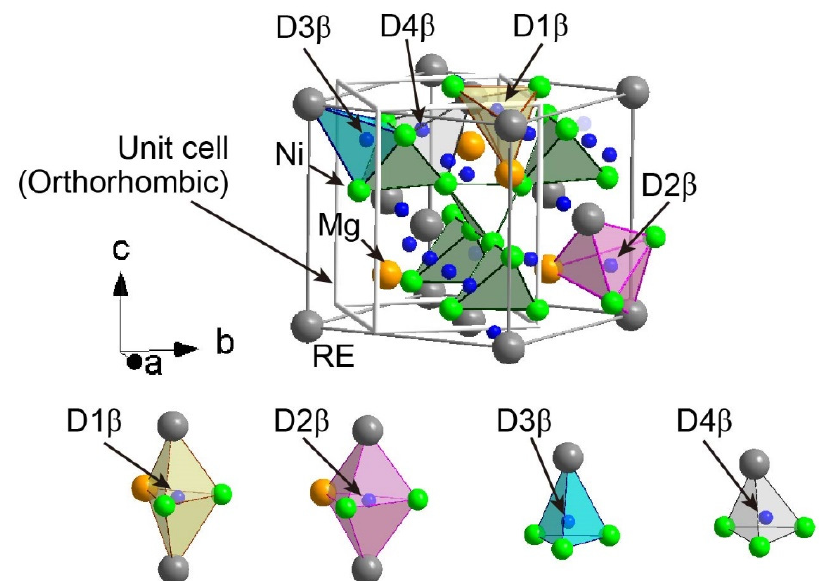
Figure 4. Crystal structure of β hydride, based on Y 1.06 Mg 0.94 Ni 4.00 D 3.86 [20]. The Y, Mg, and Ni D atoms are represented by grey, orange, and green circles, respectively. Parts of Mg atoms are replaced by Y atoms. The corner-shared tetrahedra formed by four Ni atoms are represented as the green polyhedra. The original orthorhombic unit cell is represented as white line. The grey lines connect the Y atoms in Y 1.06 Mg 0.94 Ni 4.00 D 3.86 to compare it with the unit cell of REMgNi 4 (Figure 1). In the local atomic arrangements around the D atoms, the hydrogen sites in the triangular bipyramid, and the tetrahedra are represented as yellow (D1 β ), pink (D2 β ), cyan (D3 β ), and green (D4 β ) polyhedral, respectively.